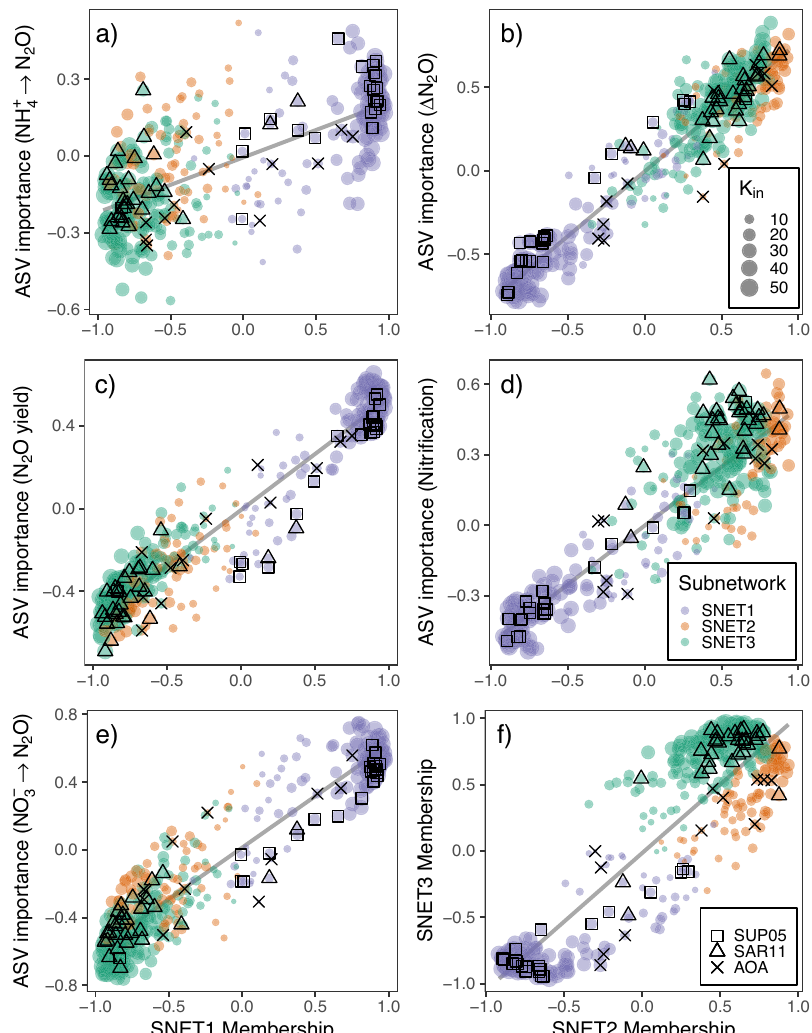
Fig. 4 Relationships between ASV subnetwork memberships and ASV importance in predicting various N 2 O cycle proxies. Left panels depict relationships between SNET1 memberships and ASV importance in predicting a rates of N 2 O production from NH 4 + oxidation, c N 2 O yields from nitri fi cation, and e rates of N 2 O production from NO 3 − reduction. Right panels depict relationships between SNET2 memberships and b Δ N 2 O, d nitri fi cation rates, and f SNET3 memberships. ASV importance corresponds to the Pearson coef fi cients calculated for pairwise correlations between microbial ASVs and sample traits. Colors correspond to community subnetworks inferred from WGNA and bubble size indicates degree of intranetwork connectivity (K in ) for each ASV. Black squares, crosses, and triangles denote ASVs belonging to the SUP05 clade, the Nitrosopumilaceae family, and SAR11 clade, respectively.